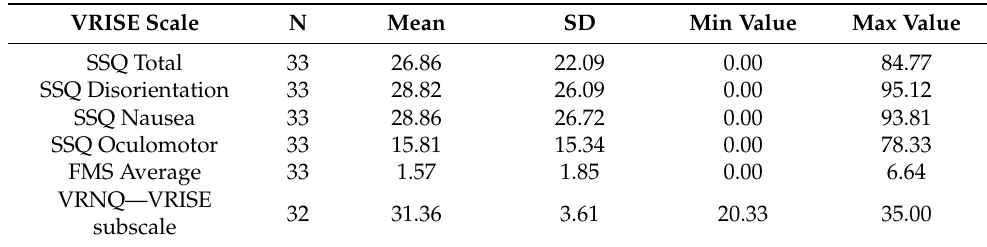
Table 10. Subjective average VRISE levels assessed by SSQ, FMS, and VRNQ (VRISE Section) Questionnaire.